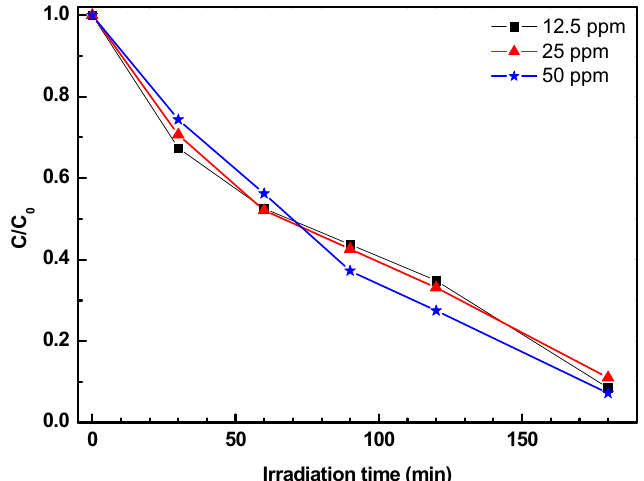
Figure 8. Phenol concentration in aqueous solutions, with phenol initial amount in the range 12.5–50 ppm, treated with the 2ZnO/s-PS δ -form aerogel.